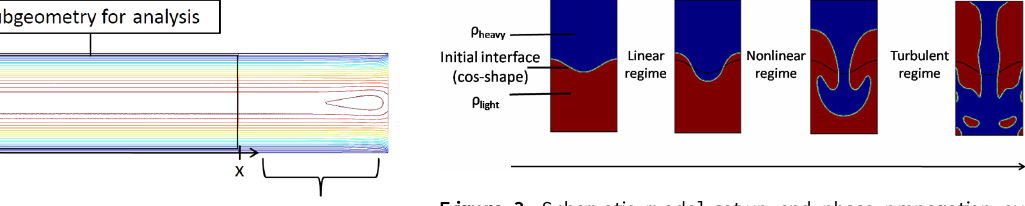
Figure 3. Schematic model set-up and phase propagation over time of the model validation using Rayleigh-Taylor instabilities. All Rayleigh-Taylor instability stages in the form of linear, nonlinear and turbulent regime are visualized. Blue and red colours represent heavier ( ρ heavy here: H 2 O) and lighter fluid ( ρ light here: CO 2 ) . For comparability, the cosine-shaped initial interface is given continu- ously as a black line, while the propagating interface is illustrated in grey.